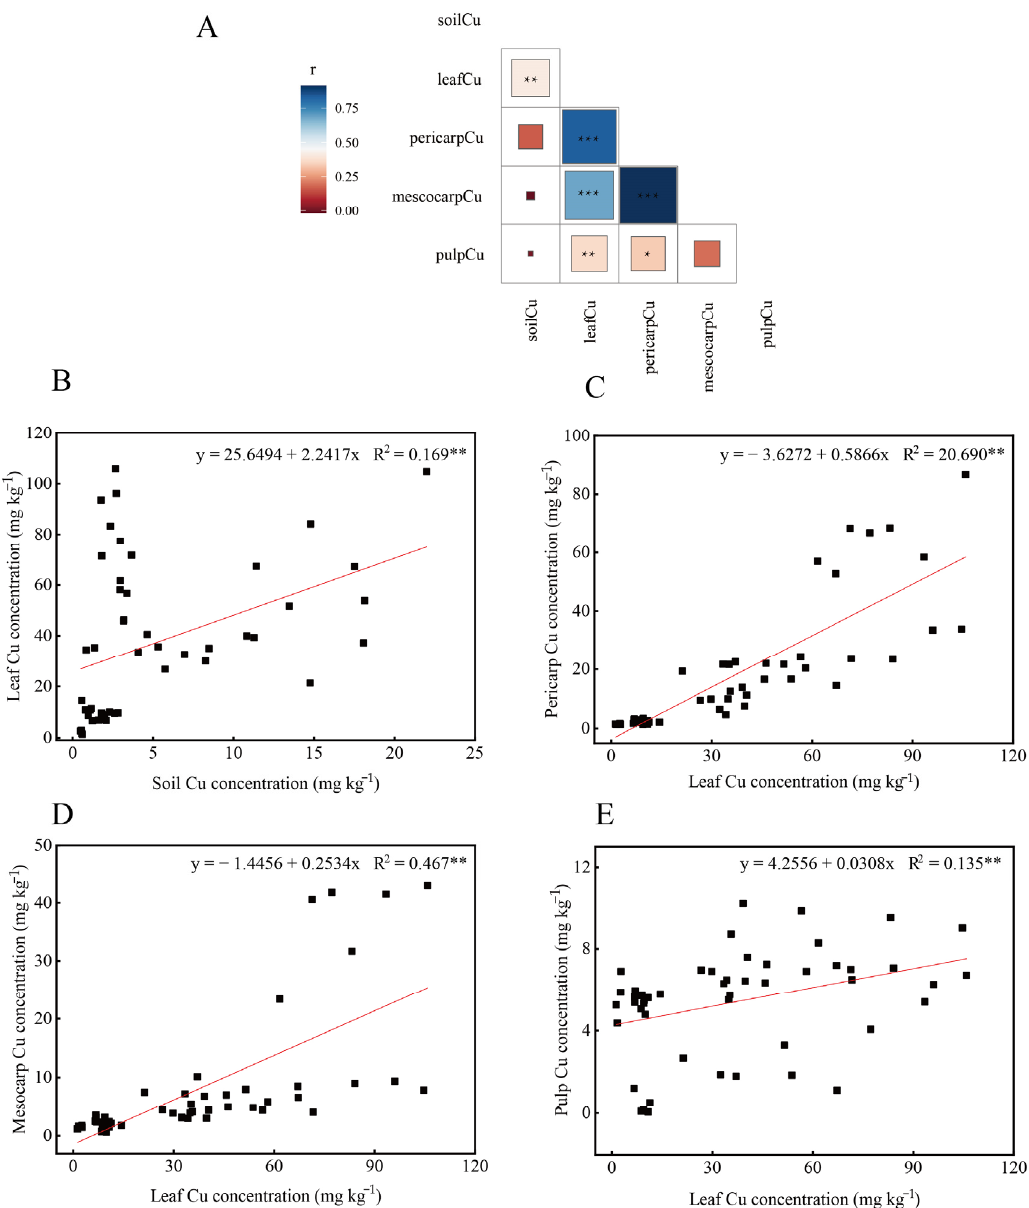
Figure 3. Correlation analysis and linear regression analysis of soil available Cu versus plant Cu in orchards under different soil Cu levels. ( A ) Correlation analysis; ( B – E ) linear regression analysis. *, ** and *** represented in the heatmap and superscripted after R 2 values indicate statistical differences at p < 0.05, p < 0.01, p < 0.001, respectively.